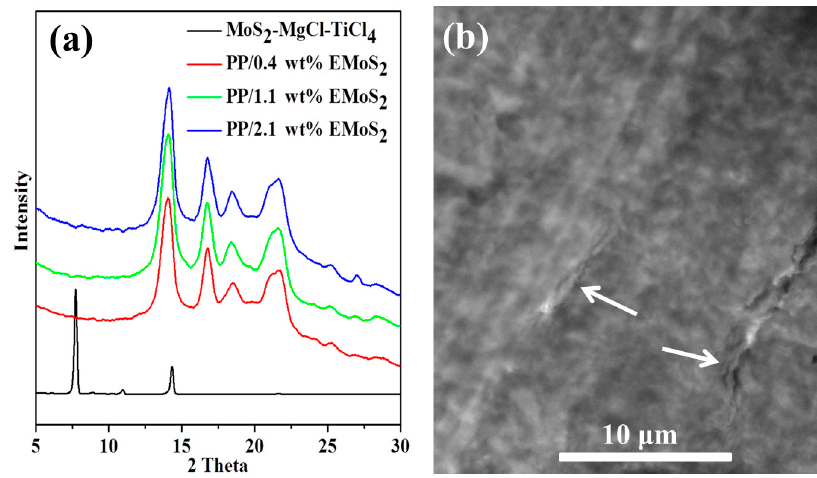
Figure 4. XRD spectra ( a ) of PP/EMoS 2 nanocomposites and TEM image ( b ) of PP with 2.1 wt % EMoS 2 .